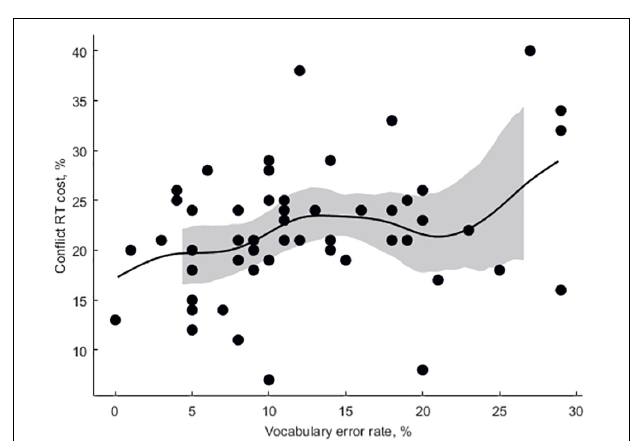
FIGURE 4 | The log-transformed item corpus frequency as a function of the competent participants number per item (Eilers smoothing).